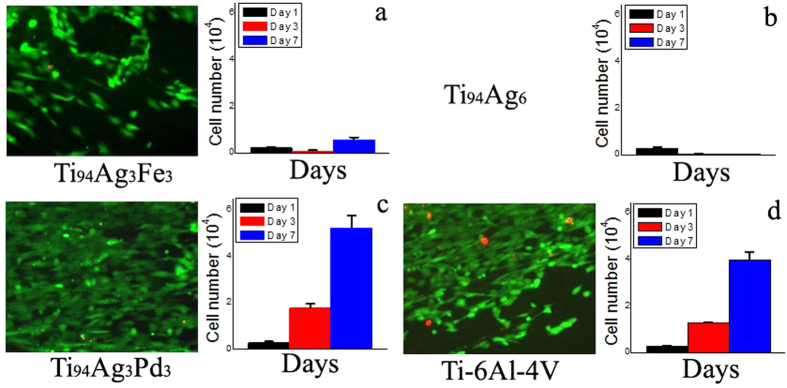
Cell proliferation and phenotypes on the surfaces of the Ag-bearing alloys and industrial Ti-6Al-4V alloy: Ti94Ag3Fe3 (a) Ti94Ag6 (b) Ti94Ag3Pd3, (c) and Ti-6Al-4V (d).Cell number and live/dead cell staining, magnification: 10×, after 7 days of culture. Significant differences (unpaired Student’s t-test): P < 0.05.